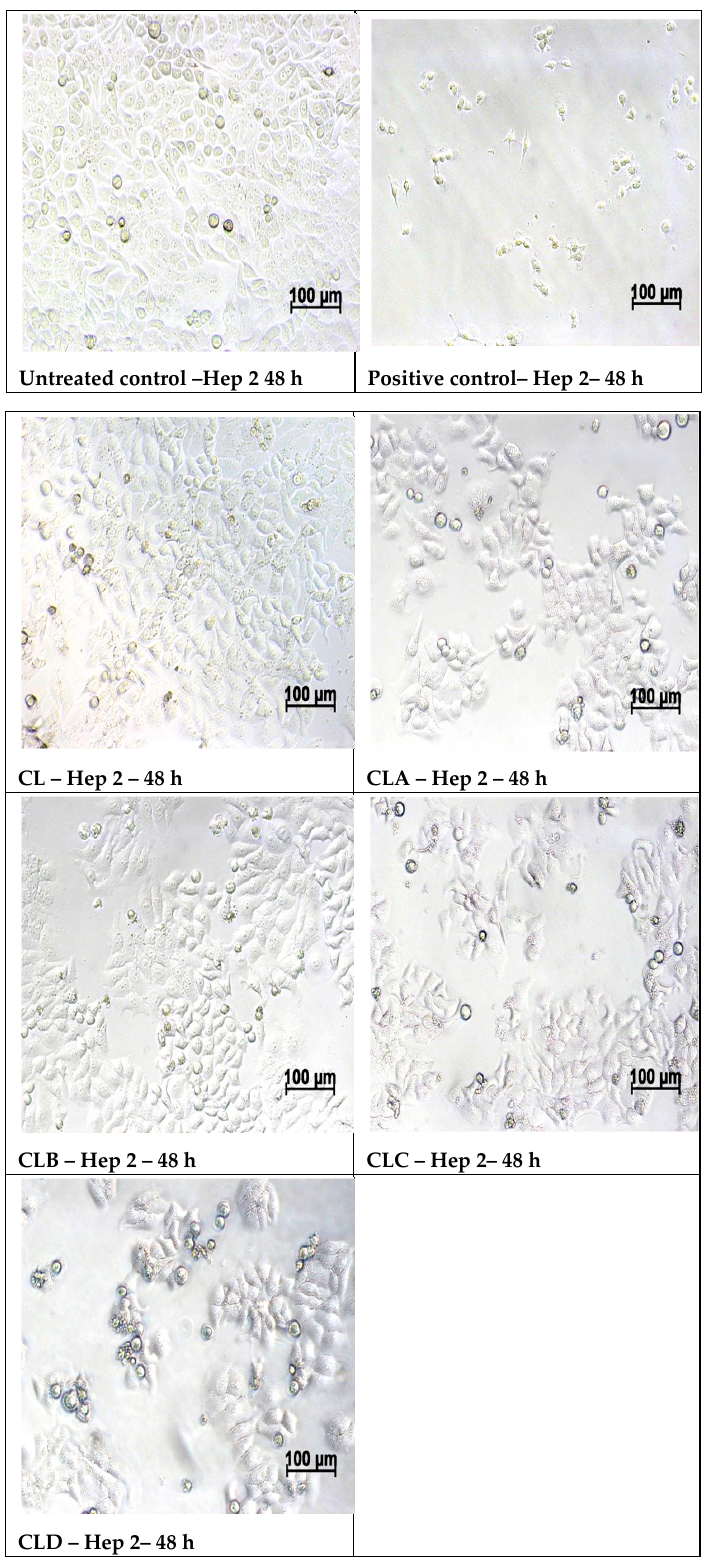
Figure 10. Optical microscopy images of the Hep-2 tumor cells after 48 h of treatment with nanoparticles’ samples.